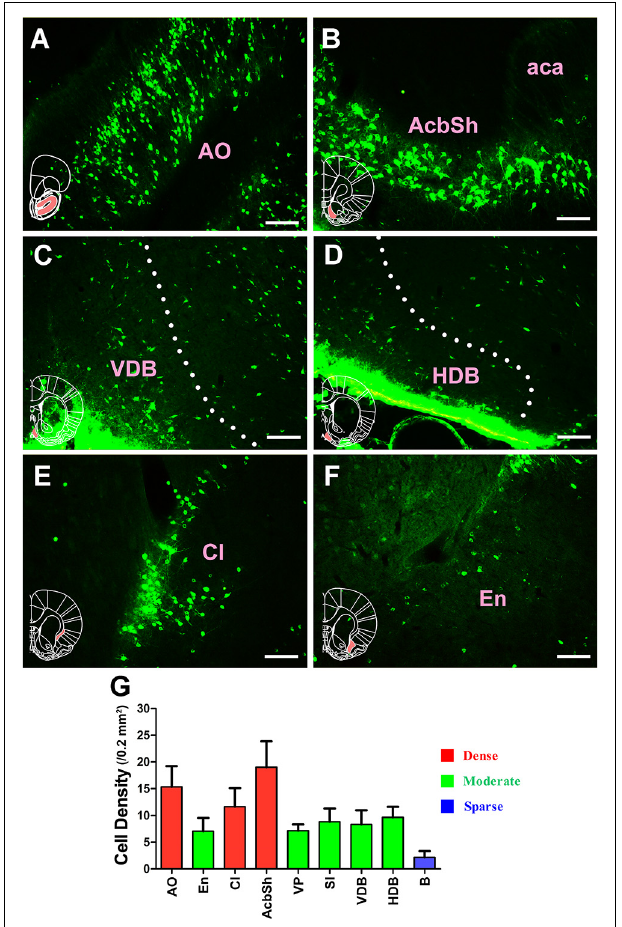
FIGURE 3 | Distribution of cholera toxin subunit B-positive neurons in the basal forebrain. (A–F) The positive neurons in AO, AcbSh, VDB, HDB, Cl, and En. (G) Statistics of the input amounts of cholera toxin subunit B-positive cells from the basal forebrain to the CSF-contacting nucleus (mean ± SD, n = 6; AO, anterior olfactory nucleus; aca, anterior commissure anterior part; AchSh, accumbens nucleus shell; VDB, nucleus of the vertical limb of the diagonal band; HDB, nucleus of the horizontal limb of the diagonal band; Cl, claustrum; En, endopiriform nucleus). Bar = 100 µ m.